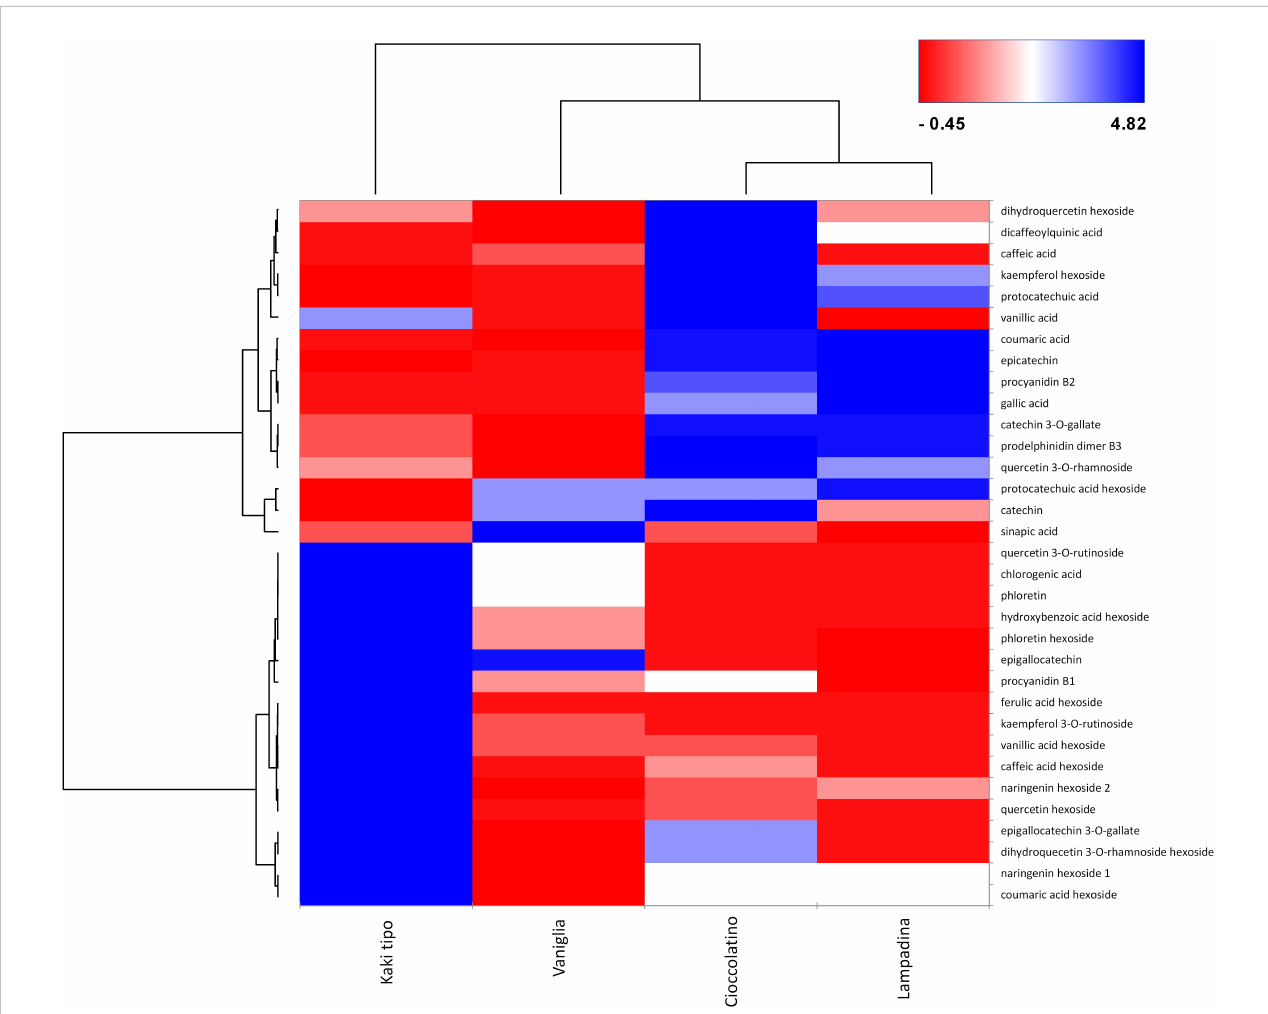
FIGURE 7 Heat-map reporting the variable abundance of polyphenols in persimmon fruits of Kaki tipo, Cioccolatino, Vaniglia and Lampadina cultivars. Each column corresponds to a cultivar, whereas each row represents a compound. Heat-map encompassed centered and reduced intensities (area counts) moving from red to blue, through white, including Euclidean distance function and Ward linkage method. The dendrograms from the hierarchical cluster analysis of the columns and the rows illustrate the similarity of the cultivars and the distribution of polyphenolic compounds between aglycones and glycosides (top and bottom section),